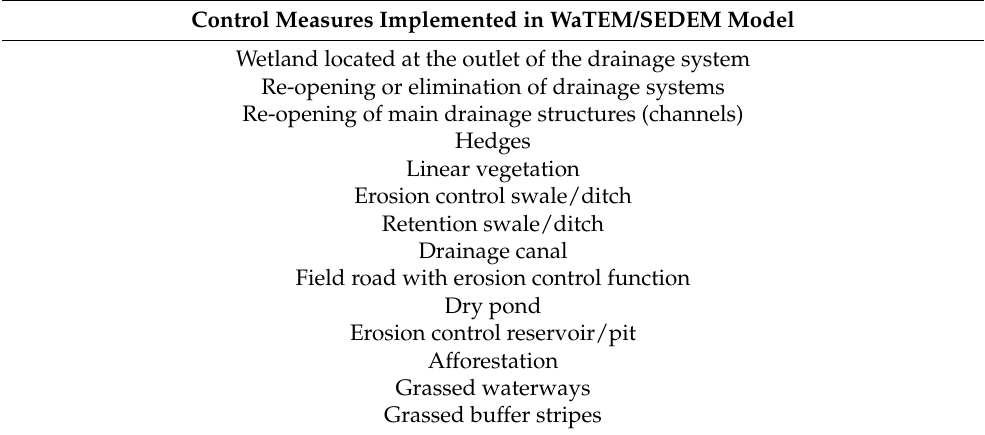
Table 3. An overview of control measures implemented in the sediment transport model to reduce non-point source water pollution (runoff and sediment transport).